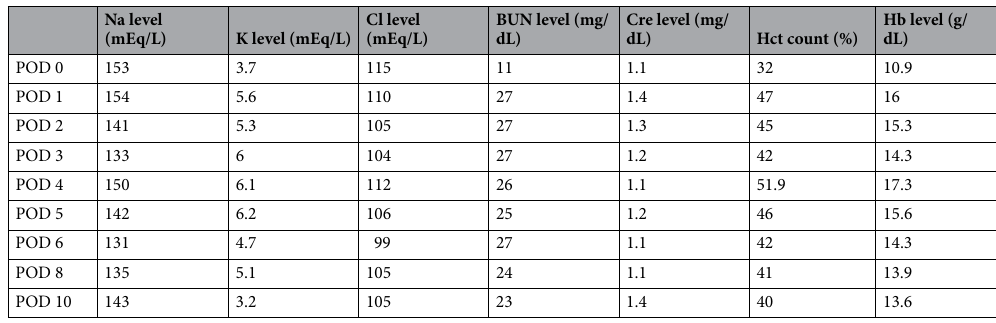
Table 2. Time course of postoperative blood examination in the monkey postoperatively. BUN blood urea nitrogen, Cl chloride, Cre creatine, Hb hemoglobin, Hct hematocrit, K potassium, Na sodium, POD postoperative day.